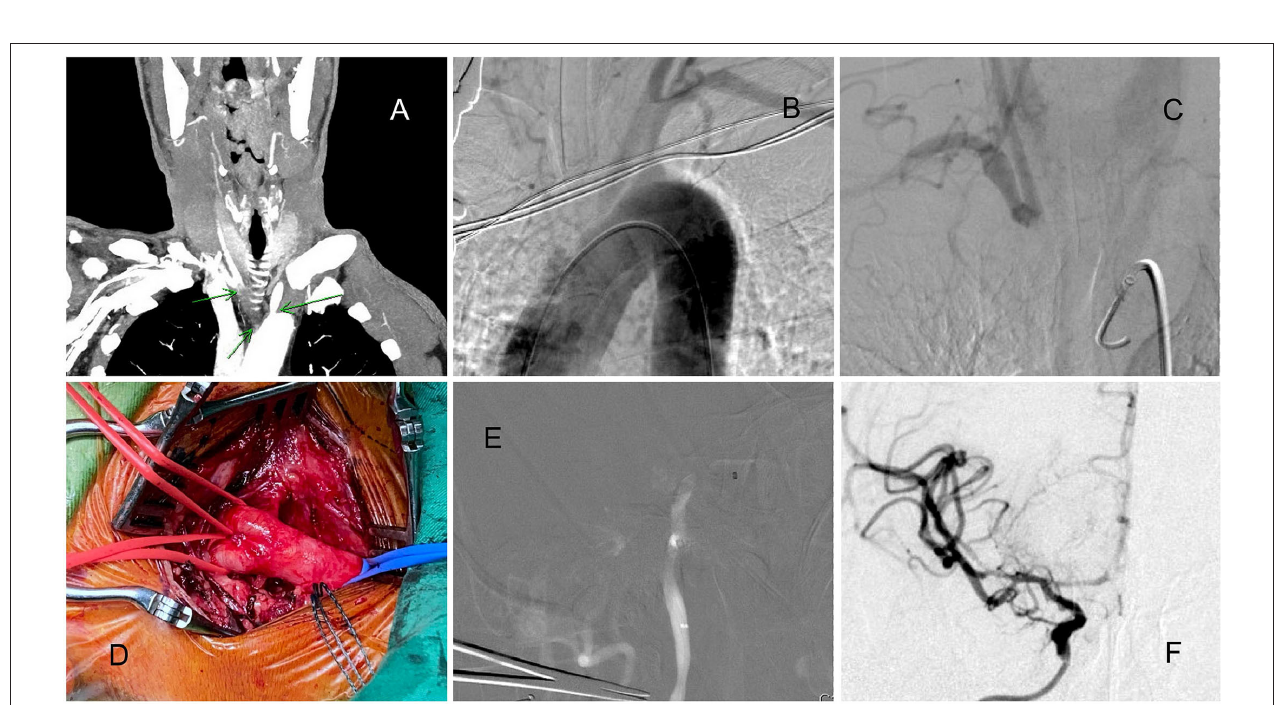
FIGURE 4 | A patient with acute ICA and MCA total occlusion with chronic brachiocephalic trunk occlusion. (A) CTA indicating brachiocephalic trunk occlusion. (B) Aortogram indicating brachiocephalic trunk occlusion. (C) Retrograde collateral flow to the right CCA. (D) The carotid artery was directly explored from the neck. (E) The Sofia aspiration catheter was navigated to the occlusion site. (F) After 2 aspiration passes, total recanalization was achieved.